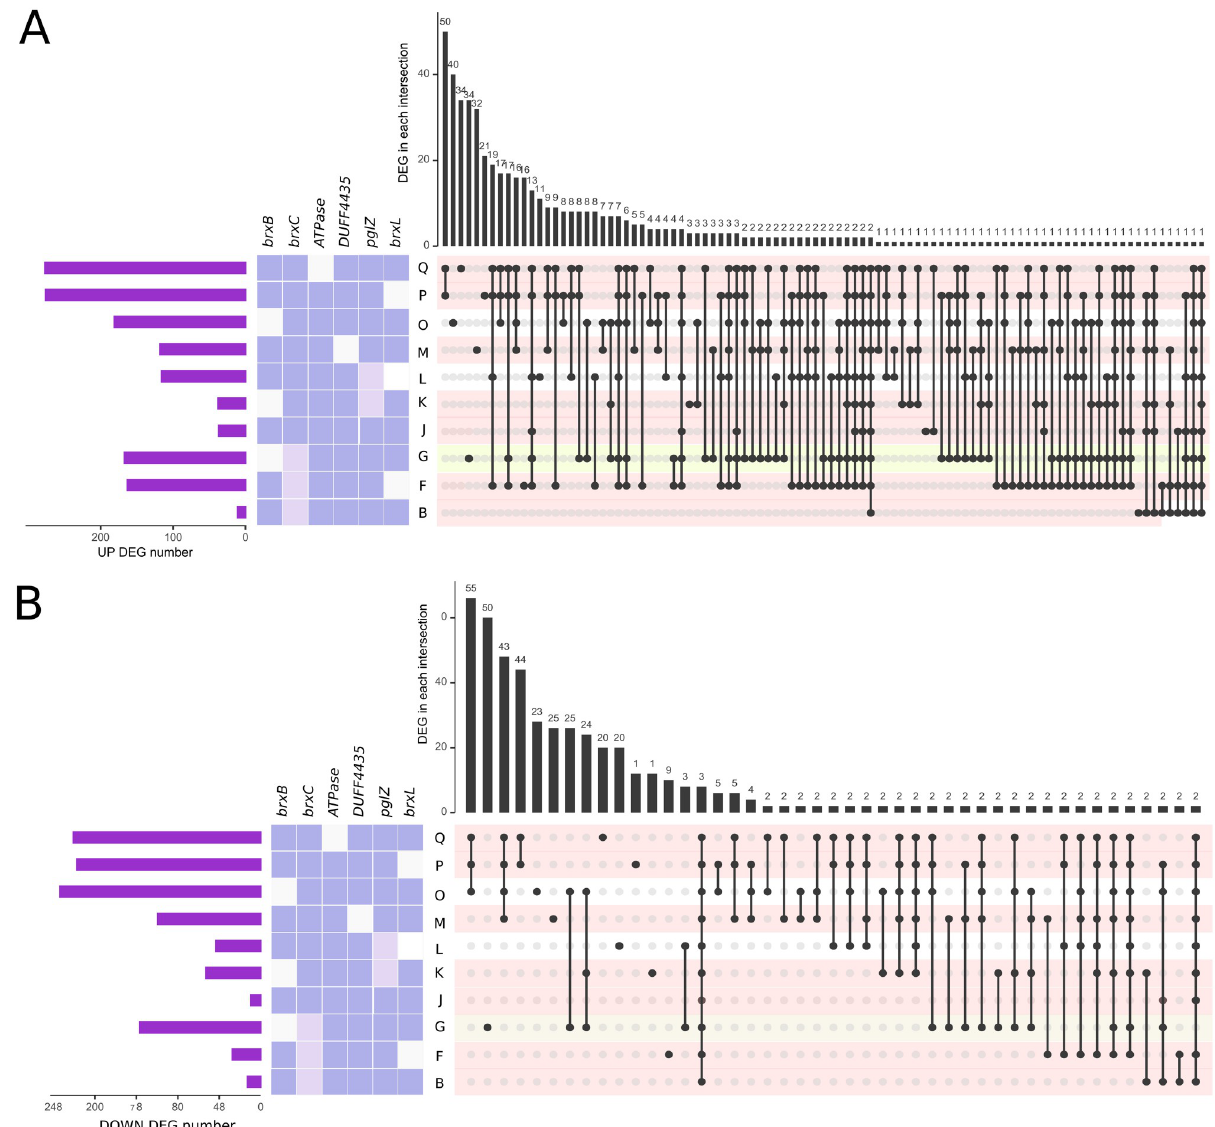
Fig 6. Global changes in transcription visualized with UpsetR. Differentially expressed genes (DEG) genes were evaluated for each CDS feature annotated in the ancestral sequence (ER3625) using RNASeq reads. Each row displays results for one strain. Changed transcription was reported as adjusted pvalue (see text). In the leftmost column, the purple bar chart shows the total number of DEG for the strain. In the middle, each the genotype is color coded: white, cat cassette replaced a segment of the CDS; dark purple, WT; light purple, μ allele inherited from ER3625. Strain code is from Table 1. On the right, sets of genes with changed transcription that are shared with other strains are represented by dots connected by lines. In each row, a black dot represents a set of genes in a particular strain. Between rows, lines connect that dot (set) to other strains with dots representing the same set. The histogram at the top indicates the number of genes in that set (intersecting group). Panel A: upregulated; Panel B: downregulated sets of genes. In each row, methylation phenotype is coded pink (M + ), yellow (Mpartial) and white (M - ).